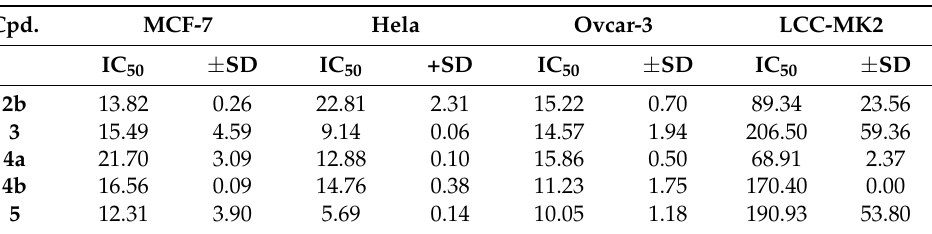
Table 2. IC 50 for tested compounds against different cell lines, in µ g/mL.